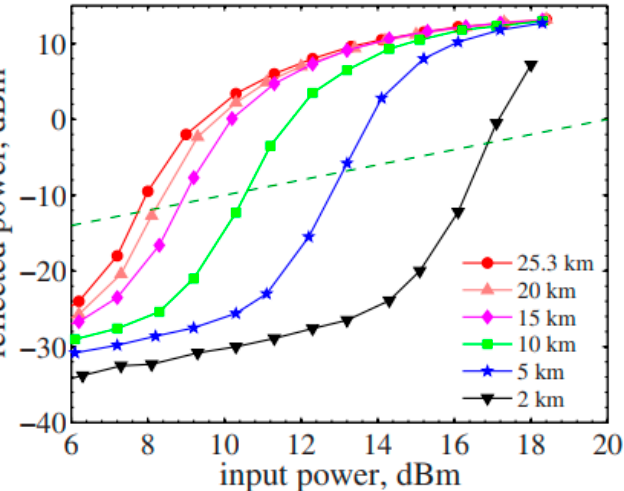
Figure 6. The measured dependence of the Stokes power P s ( 0 ) on the input power P 0 for various fiber lengths. [Reprinted/Adapted] with permission from [61] © The Optical